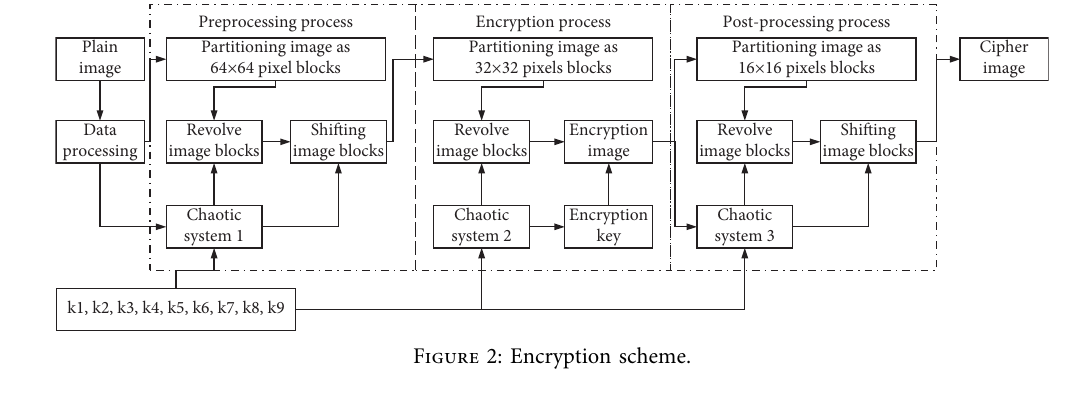
Figure 2: Encryption